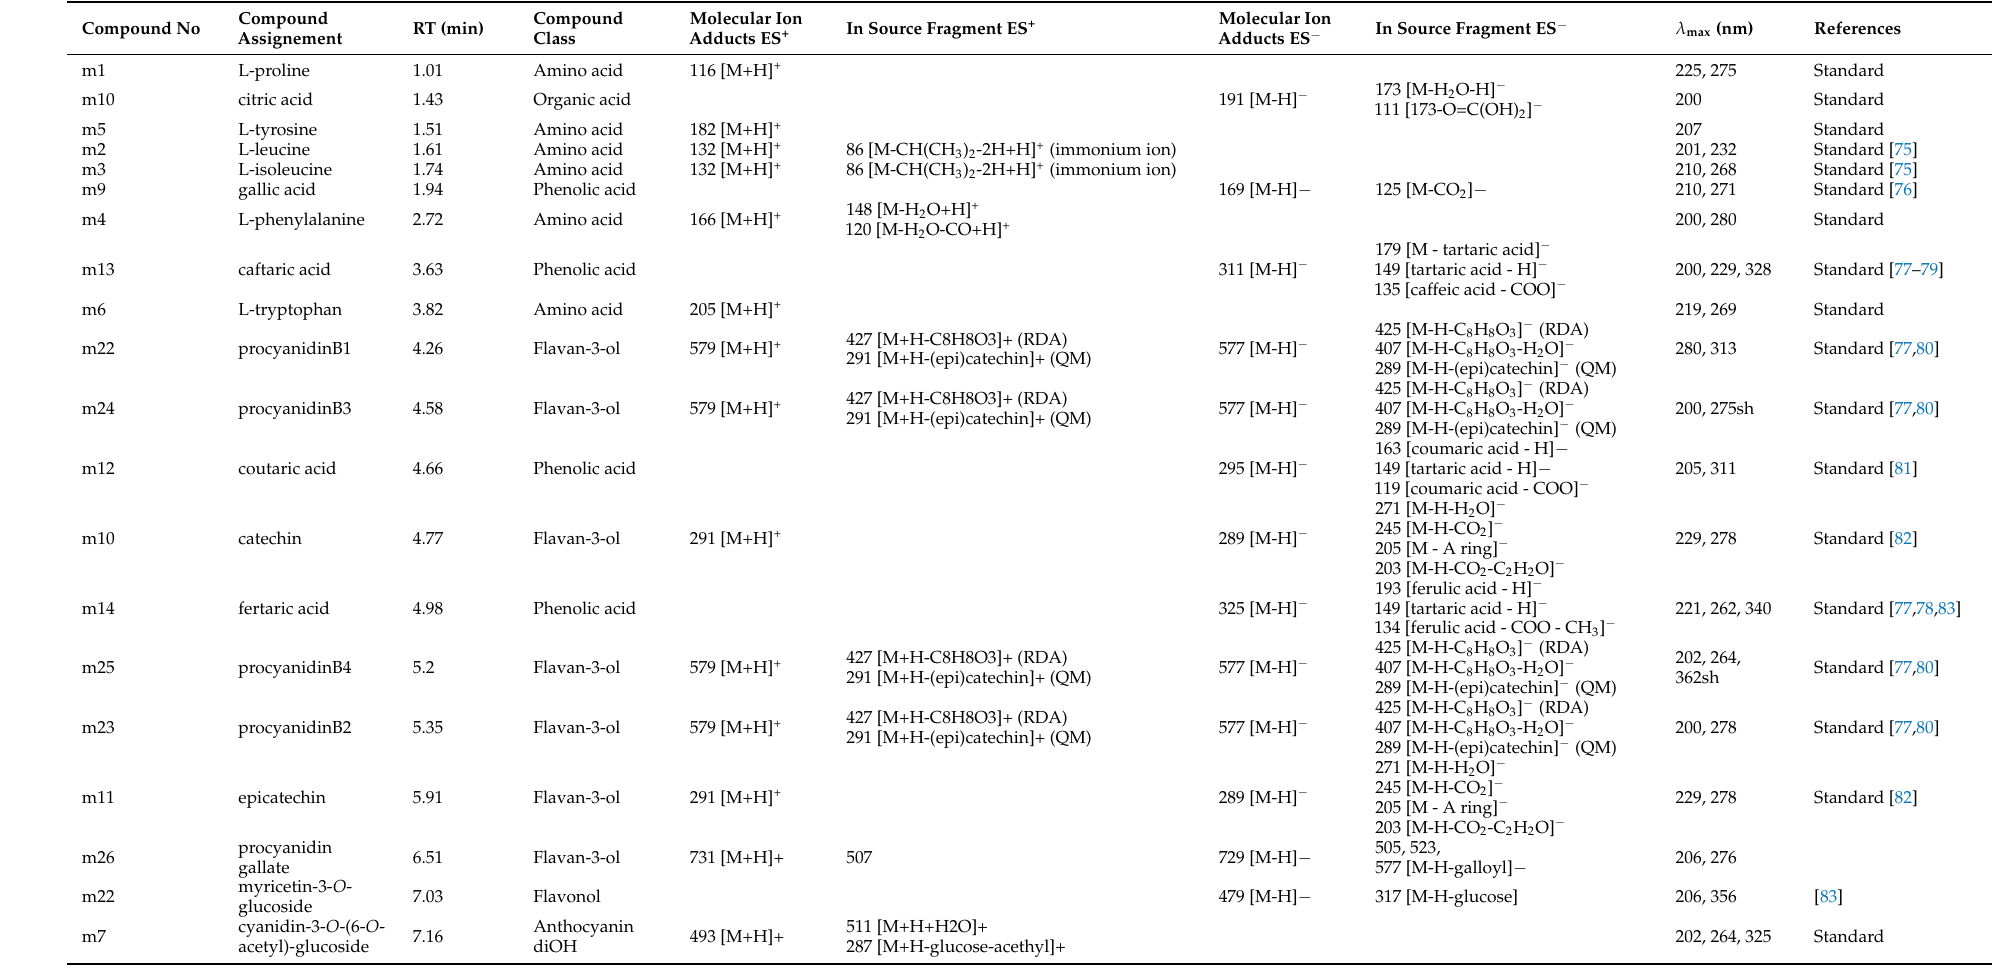
Table 2. List of compounds identified in this study based on MS and UV spectra. RT retention time, * tentative assignments based on MS data, UV spectra, elution order available from